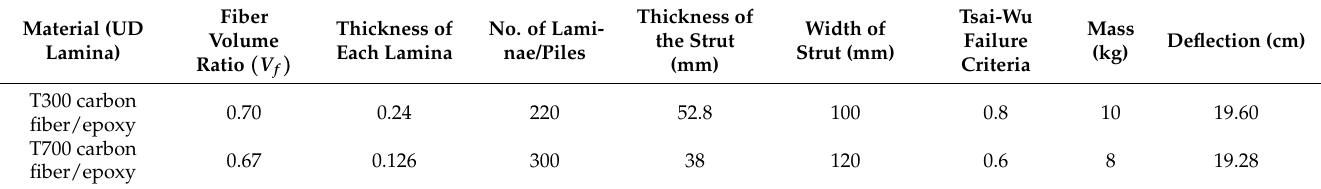
Table 3. Dimensional and properties-based comparison of landing gear assemblies composed of T700